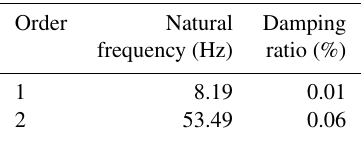
Figure 1. Dynamic model of the torsional vibration absorber. Table 1. Natural frequencies and corresponding damping ratios.